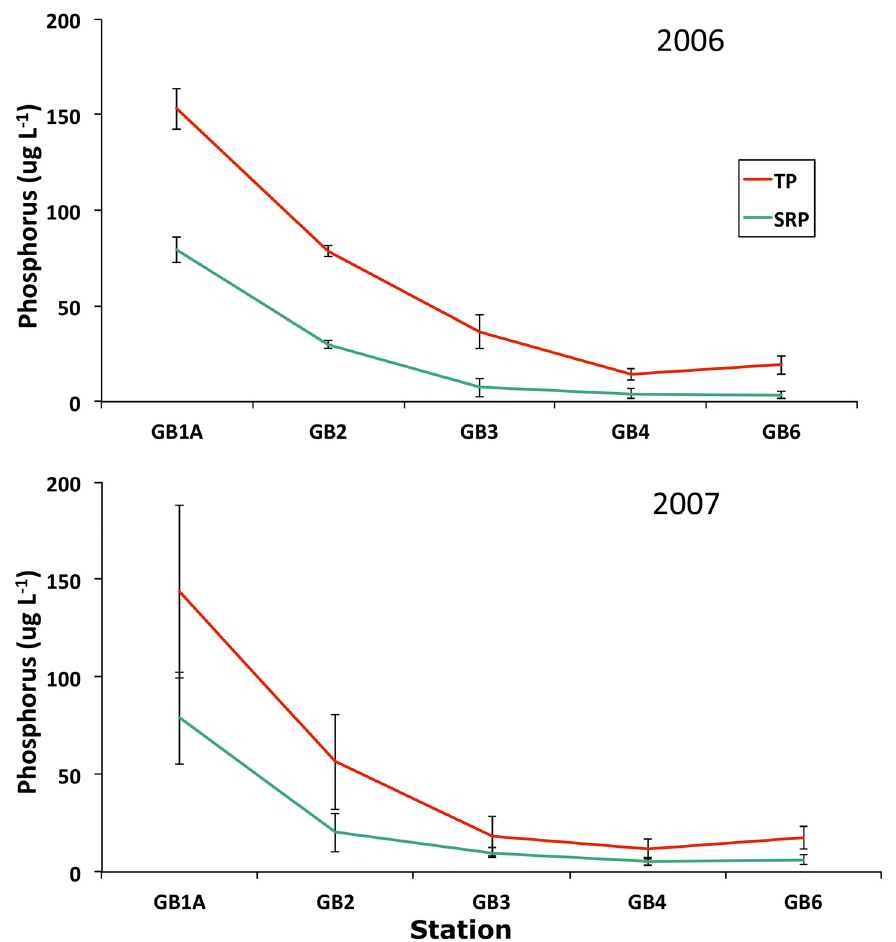
Figure 11. Phosphorus concentrations along the trophic gradient in Green Bay during 2006 (top) and 2007 (bottom). Both soluble reactive phosphorus (SRP) and total phosphorus (TP) concentrations are shown. Error bars indicate ±1